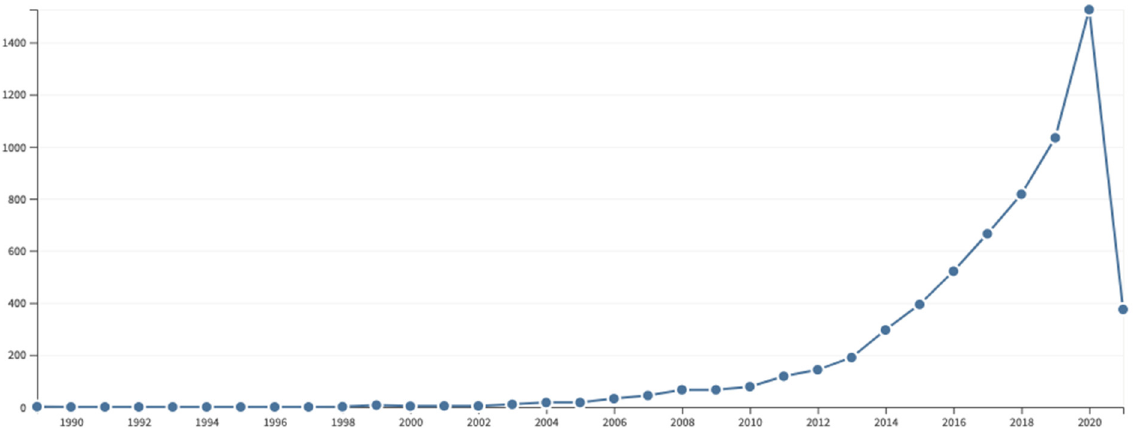
Figure 6. Sum of number of times cited per year.